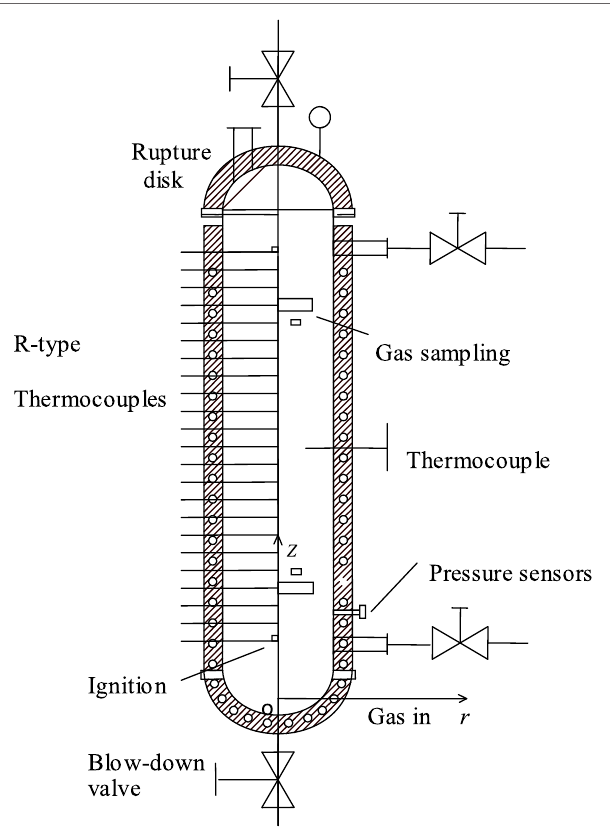
FIGURE 3 | chematic diagram of the combustion chamber/container.